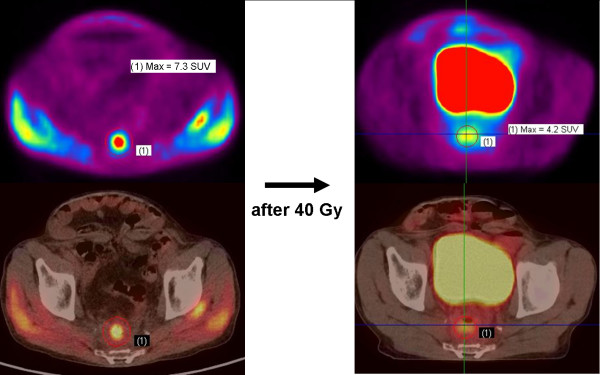
Change in FDG accumulation. This patient had anastomatic recurrence with 7.3 SUVmax before radiation therapy. After 40 Gy, the accumulation was decreased by 3.1 SUVmax.